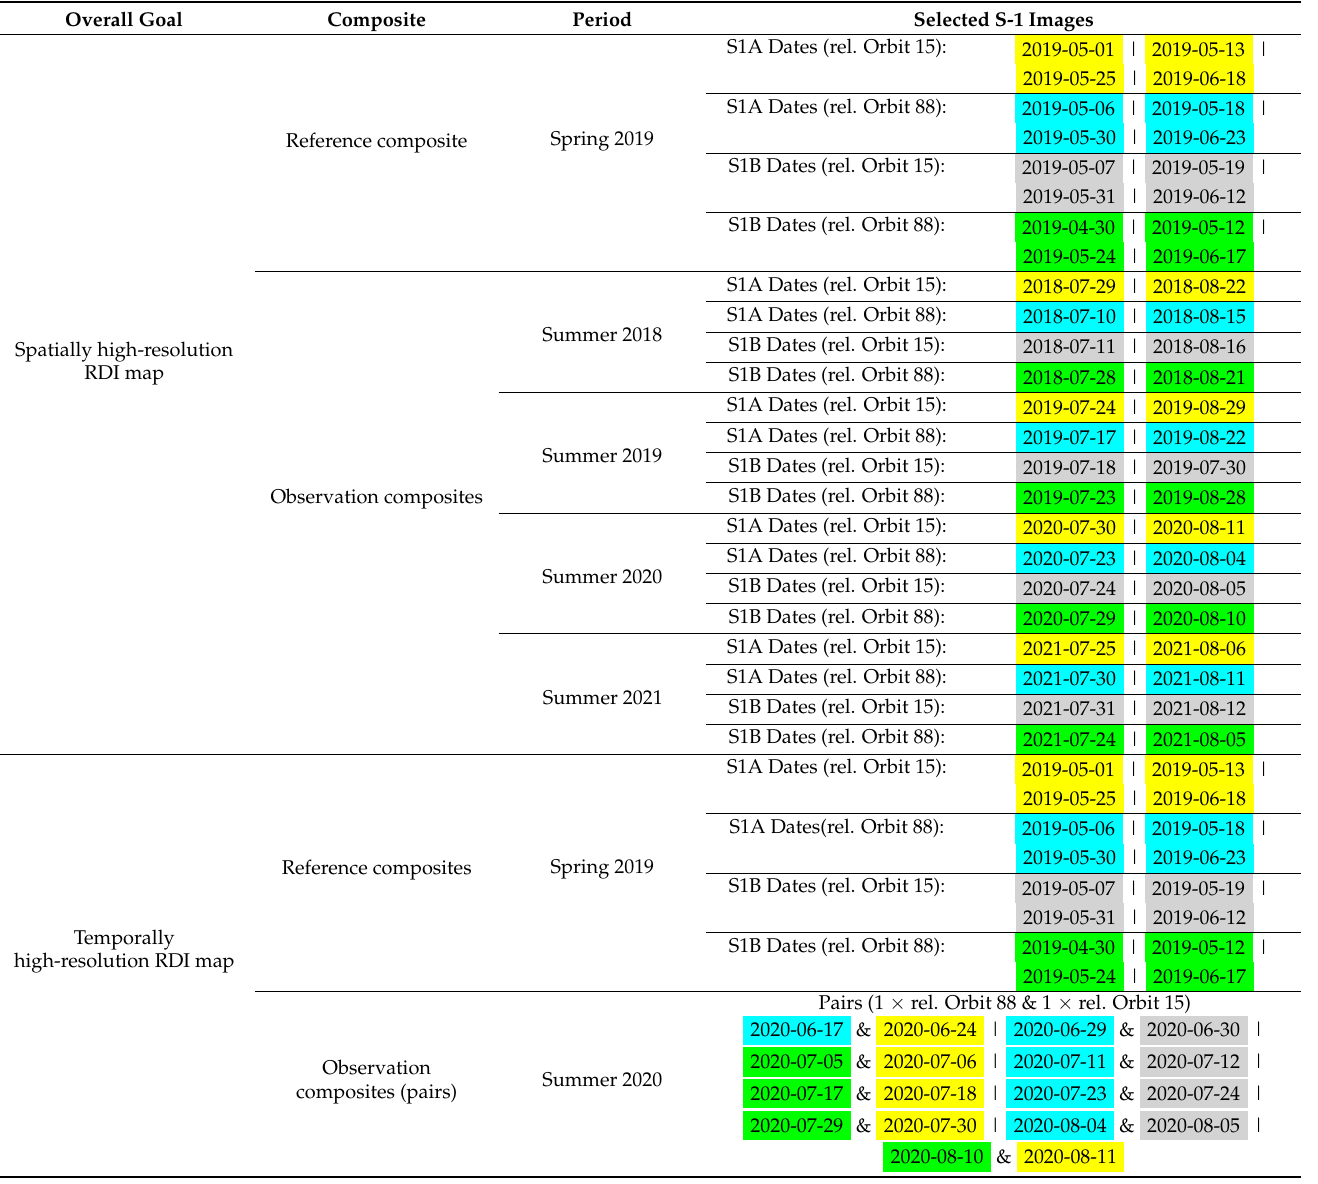
Table 1. Overview of all Sentinel-1 imagery used. Dates of used S-1 datasets are colored according to the four different viewing